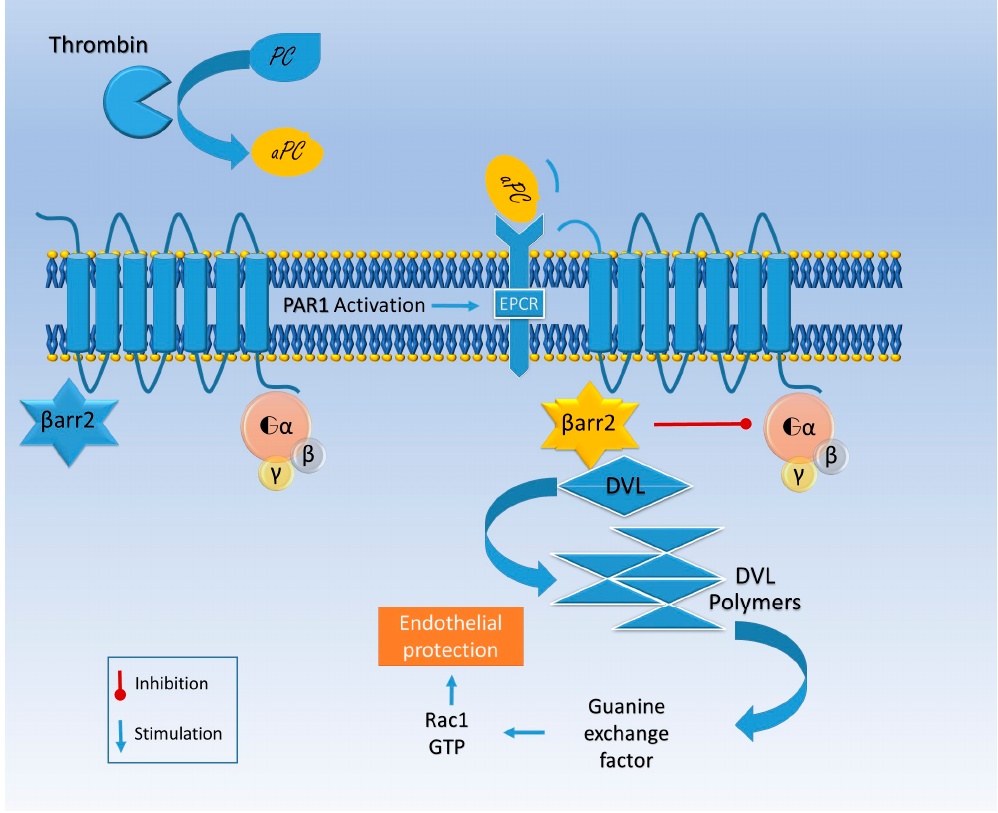
Figure 3. Representation of PAR1 activation by β arrestin 2 ( β arr2)-biased pathway in endothelial cells. Thrombin activates protein C (aPC), a protease that binds endothelial protein C receptor (EPCR), promoting a different site of PAR1 proteolytic activation. In this conformation β arr2 is released from PAR1 and promotes disheveled (DVL) polymerization. This activity is associated with guanine exchange factor, which activates Rac1 (Ras-related C3 botulinum toxin substrate 1) and endothelial stability while the G protein signal is inhibited.